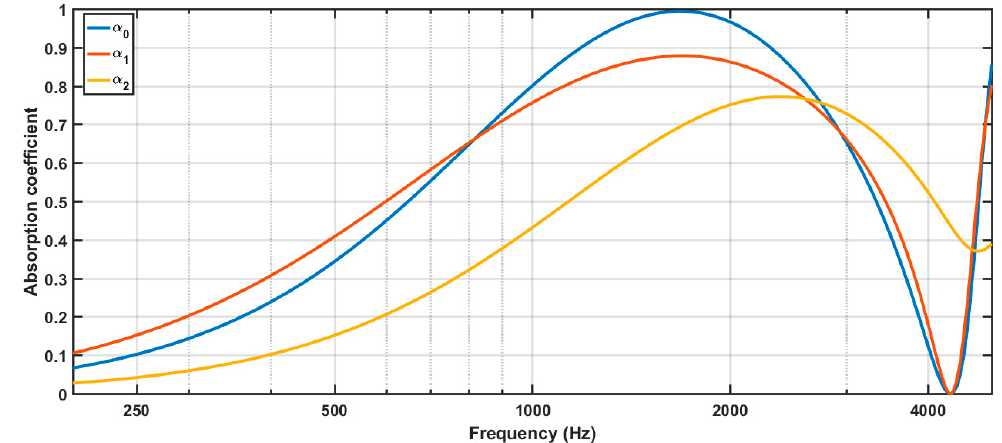
Figure 22. Absorption coefficients at normal ( α 0 ) and random incidence for local ( α d 1 ) and bulk ( α 2 ) reaction of an SL-MPP with parameters ( d , t , φ , D ) = (0.1 mm,0.1 mm, 1.8%, 4 cm).